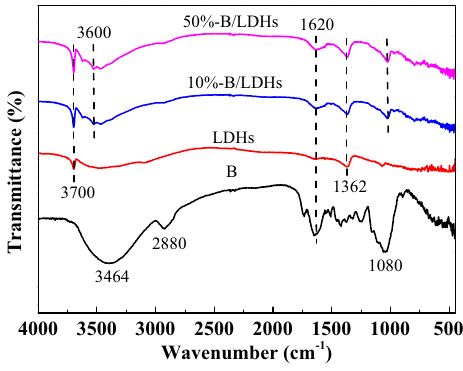
Figure 2: FT - IR spectra of 50% B/LDHs, 10% B/LDHs, Mg – Al LDHs ( LDHs ) , and soybean straw ( B ) .